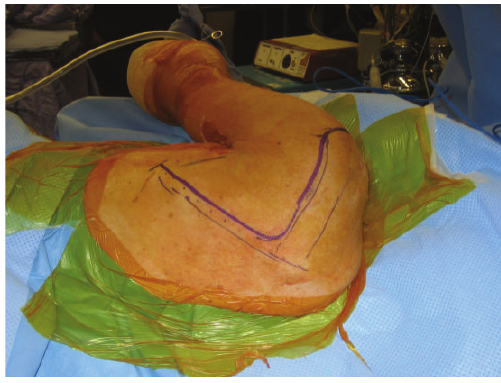
Figure 7: A full-thickness flap overlying the deltoid fascia is created, thereby exposing the posterior deltoid.